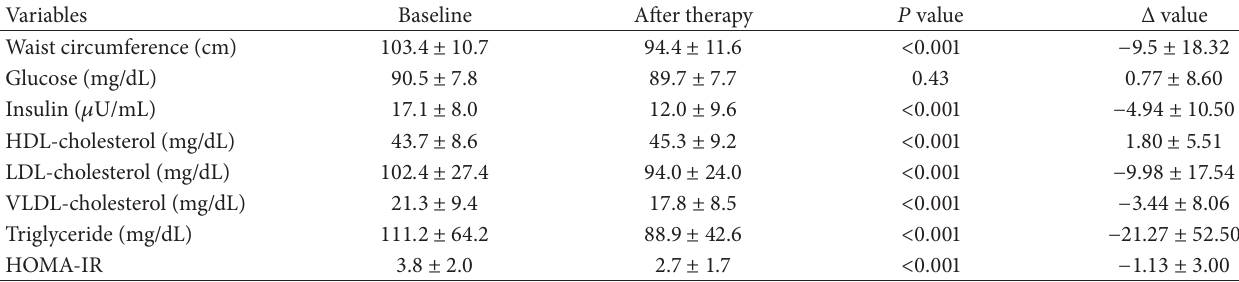
Table 3: Effects of interdisciplinary therapy in metabolic profile (factors associated with metabolic syndrome definition by International Diabetes Federation